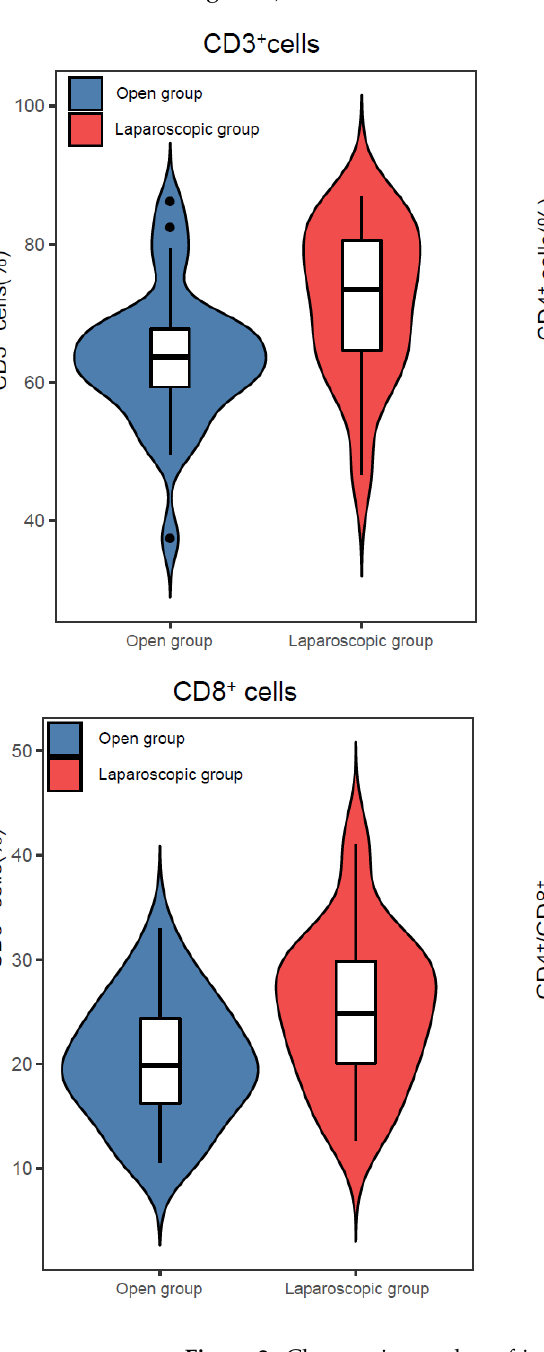
Figure 2. Changes in number of immune cells in open and laparoscopic groups at time point in post- surgery.